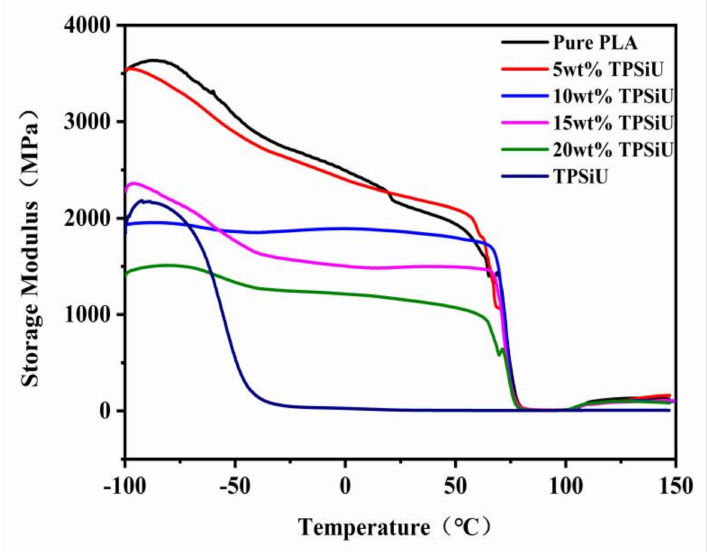
Figure 7. Temperature dependence of storage modulus E (cid:48) for PLA/TPSiU blends.